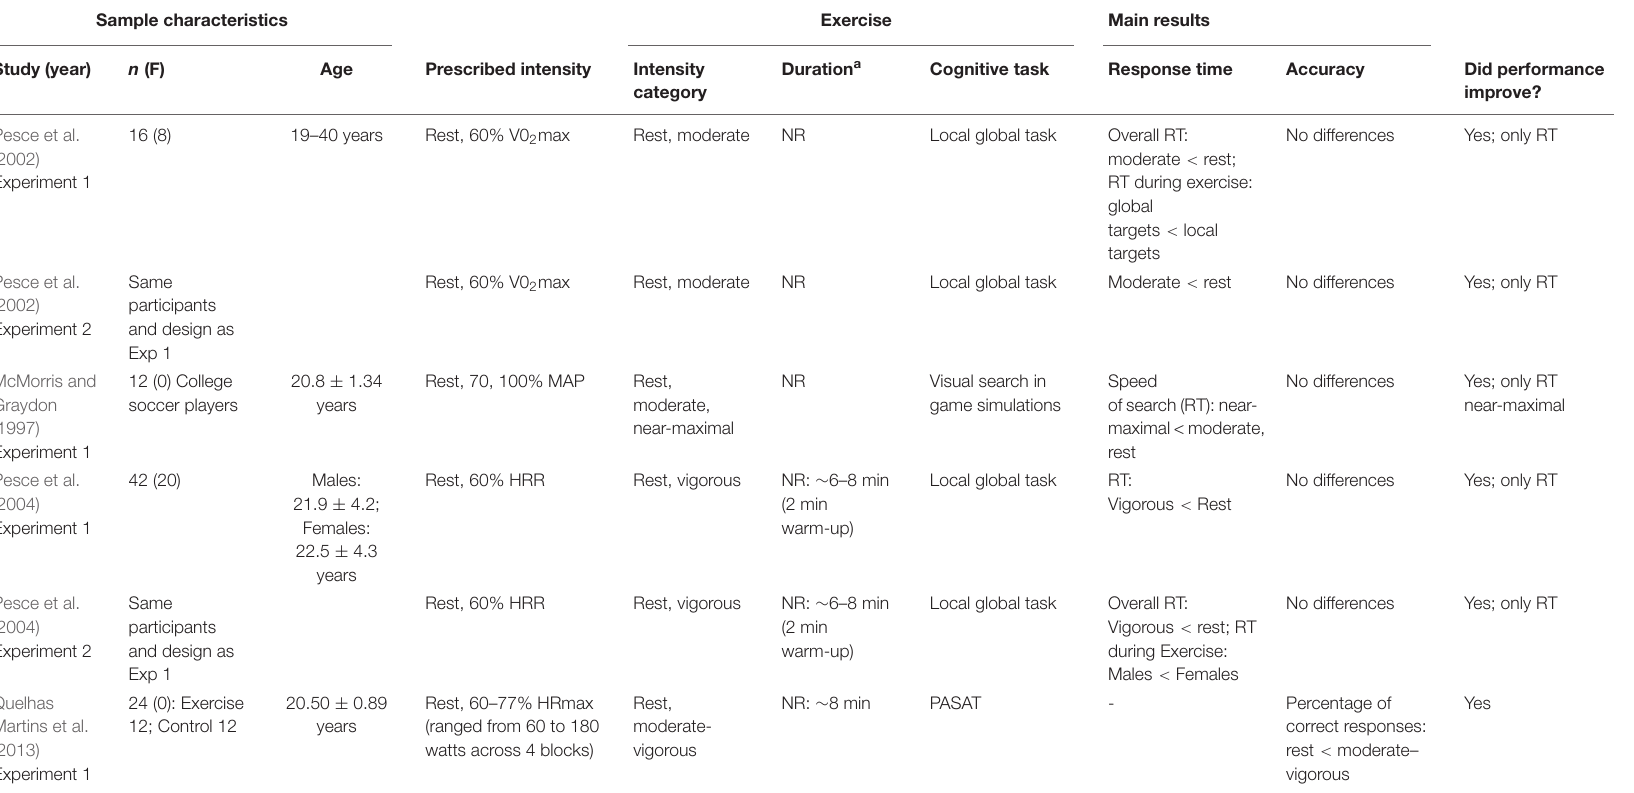
TABLE 4 | Summary of studies examining attention during acute aerobic